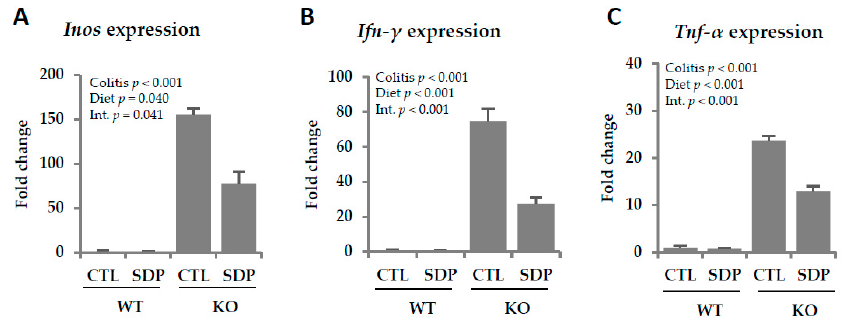
Figure 5. Effects of SDP supplementation on proinflammatory cytokine expression in the colonic mucosa of Mdr1a KO mice. ( A ) Inos expression; ( B ) Ifn- γ expression; ( C ) Tnf- α expression. Results are expressed as mean ± SEM ( n = 4–7 mice / group). CTL, control; Inos, inducible nitric oxide synthase; Ifn- γ , interferon-gamma; Int., indicates the interaction between colitis and dietary factors; SDP, spray-dried porcine plasma; Tnf- α , tumor necrosis factor-alpha.